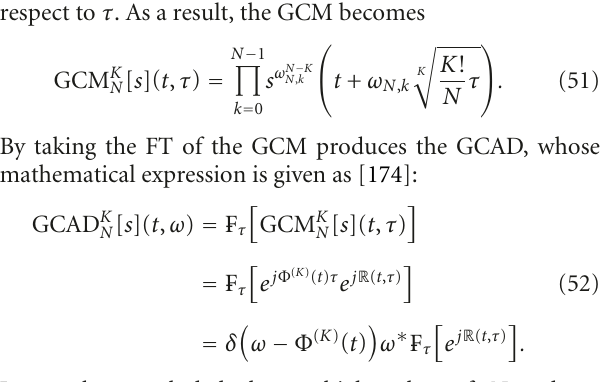
can subsequently be obtained by replacing K = 1 and 2, respectively, in